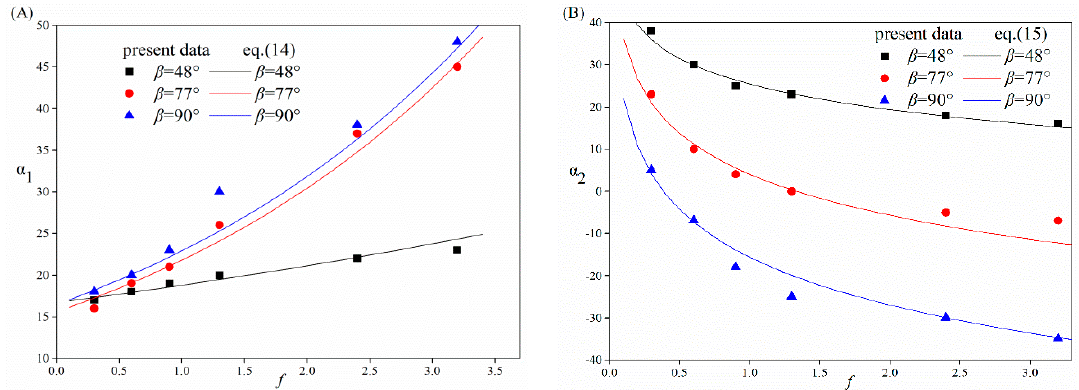
Figure 12. Comparison of the values obtained from Equations (14) and (15) with the present data. ( A ) Inner angle of α 1 , and ( B ) outer angle of α 2 .